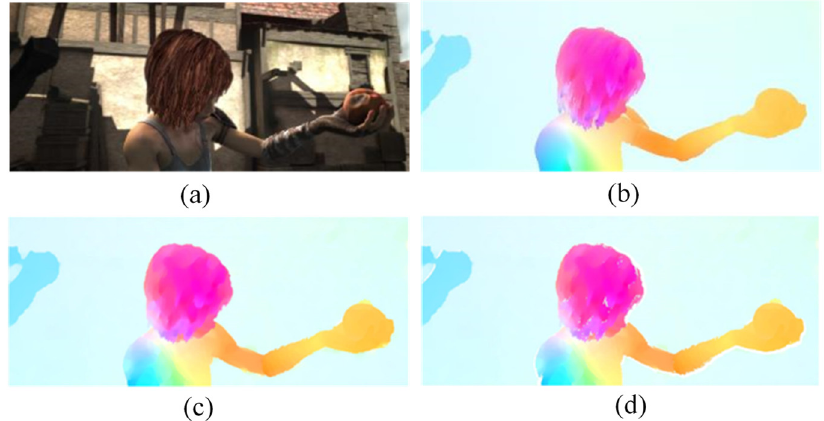
Figure 3. Optical flow estimation diagram based on motion occlusion determination. ( a ) The current image, ( b ) the ground optical flow value, ( c ) the optical flow vector estimation value without occlusion determination, and ( d ) the optical flow vector estimation after the occlusion removal value.